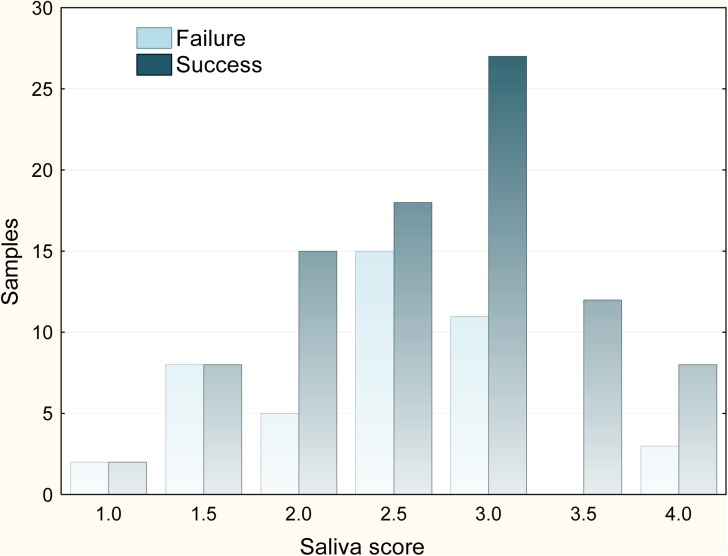
Frequencies of dog individual identification across classes of the amount of saliva attached to the substrate.Successful identification means complete agreement with 10-loci genotypes obtained from hair samples.